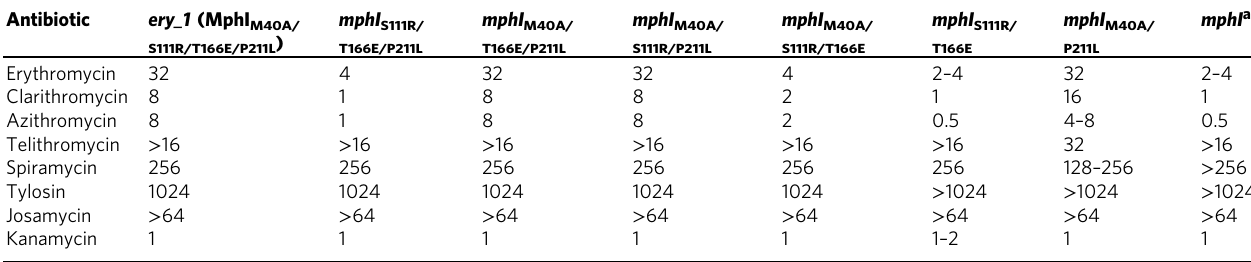
Table 2 Antibiotic susceptibility of intermediate mutants between MphI and MphI M40A/S111R/T166E/P211L expressed in E. coli BW25113 Δ bamB Δ tolC